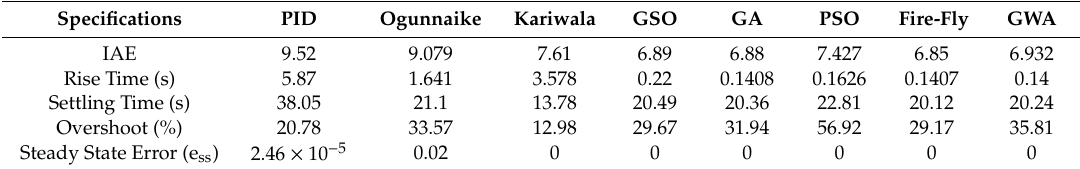
Table 5. Example 1: Performance comparison with di ff erent tuning